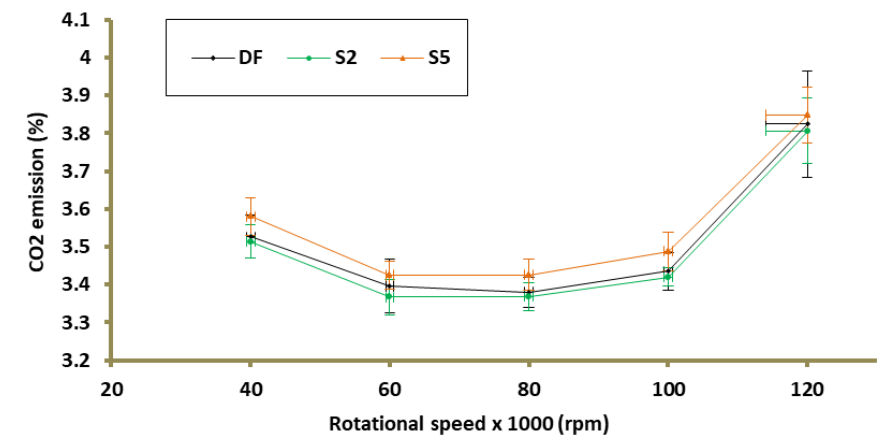
Figure 9. CO2 emission as a function of rotational speed.